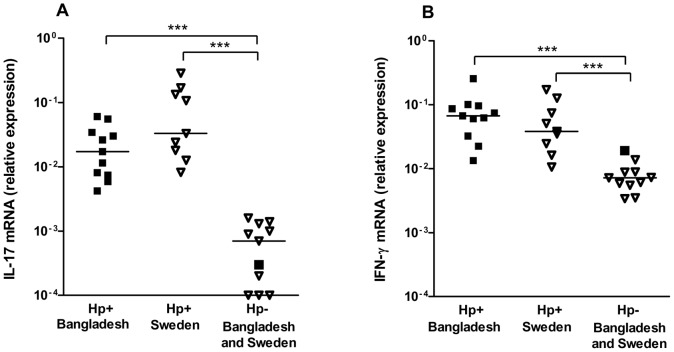
Expression of IL-17 and IFN-γ in gastric mucosa.Levels of IL-17 (A) and IFN-γ (B) mRNA were analyzed in gastric biopsy material collected from H. pylori infected (Hp+, filled symbols) and uninfected (Hp-, open symbols) Bangladeshi (squared symbols) and Swedish (triangular symbols) adults. The gene expression data is indicated as fold change normalized to an internal reference gene (HPRT) and relative to the calibrator sample. Horizontal lines represent median values (***P<0.001).